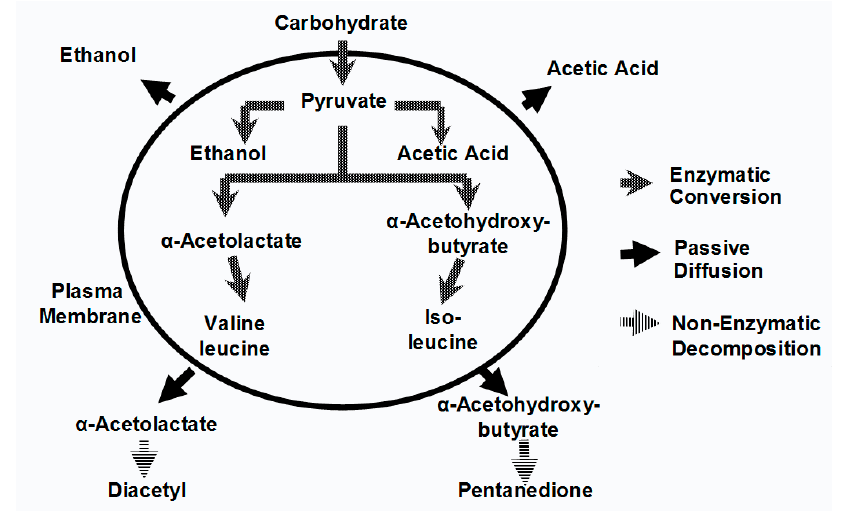
Figure 12. Formation of diacetyl and 2,3-pentandione.